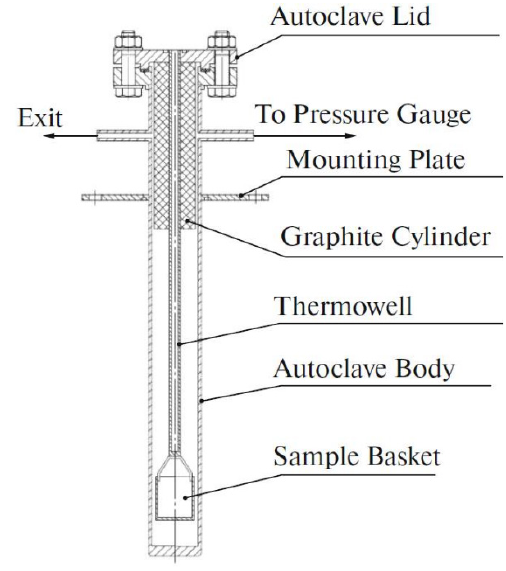
Figure 3. Scheme of the autoclave unit for catalytic reactions of tar.